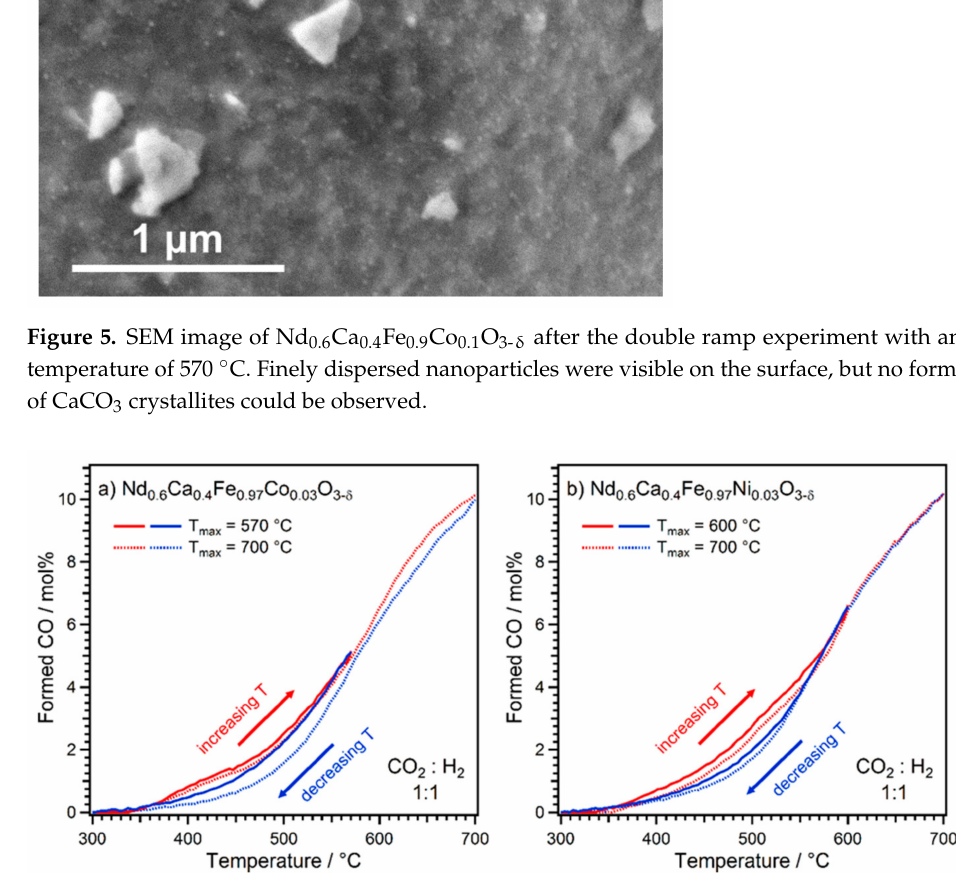
Figure 6. CO formation during double ramp rWGS experiments on ( a ) Nd 0.6 Ca 0.4 Fe 0.97 Co 0.03 O 3- δ (maximum temperatures 570 ◦ C and 700 ◦ C) and ( b ) Nd 0.6 Ca 0.4 Fe 0.97 Ni 0.03 O 3- δ (maximum temper- ature 600 ◦ C and 700 ◦ C). In all cases, a similar hysteresis loop could be observed, where reduced activities were observed during cooling (due to formation of CaCO 3 at high